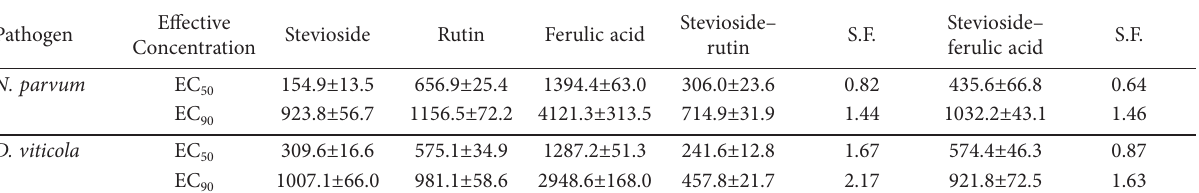
Table 2. Mean EC 50 s and EC 90 s (µg·mL −1 ; ± standard errors), and calculated synergy factors (S.F.). Pathogen